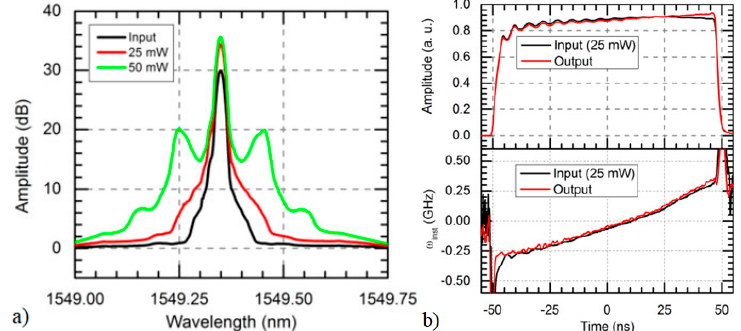
Figure 4. (From [27]) Chirped pulse characteristics after propagation along 75 km of SMF using bidirectional first-order Raman amplification, for different (25 mW, 50 mW) input pulse peak powers. The reference pulse is represented in black. ( a ) Measured optical spectrum. ( b ) Amplitude and chirp profile, @2017 IEEE [27].